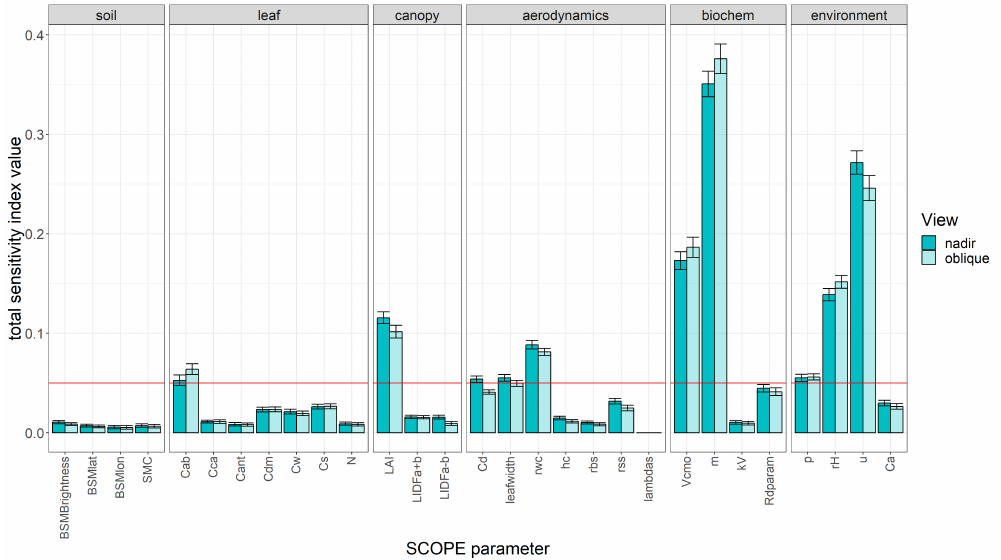
Figure A1. Total order sensitivity index (ST) as percent for land surface temperature (LST) simulated with SCOPE model from Sentinel-3 SLSTR instrument bands S8 (10.9 µ m) S9 (12 µ m) in different views: oblique (transparent), nadir (dense). Red horizontal line denotes the significance threshold (0.05 units of index value). Definitions of parameters can be found in Table